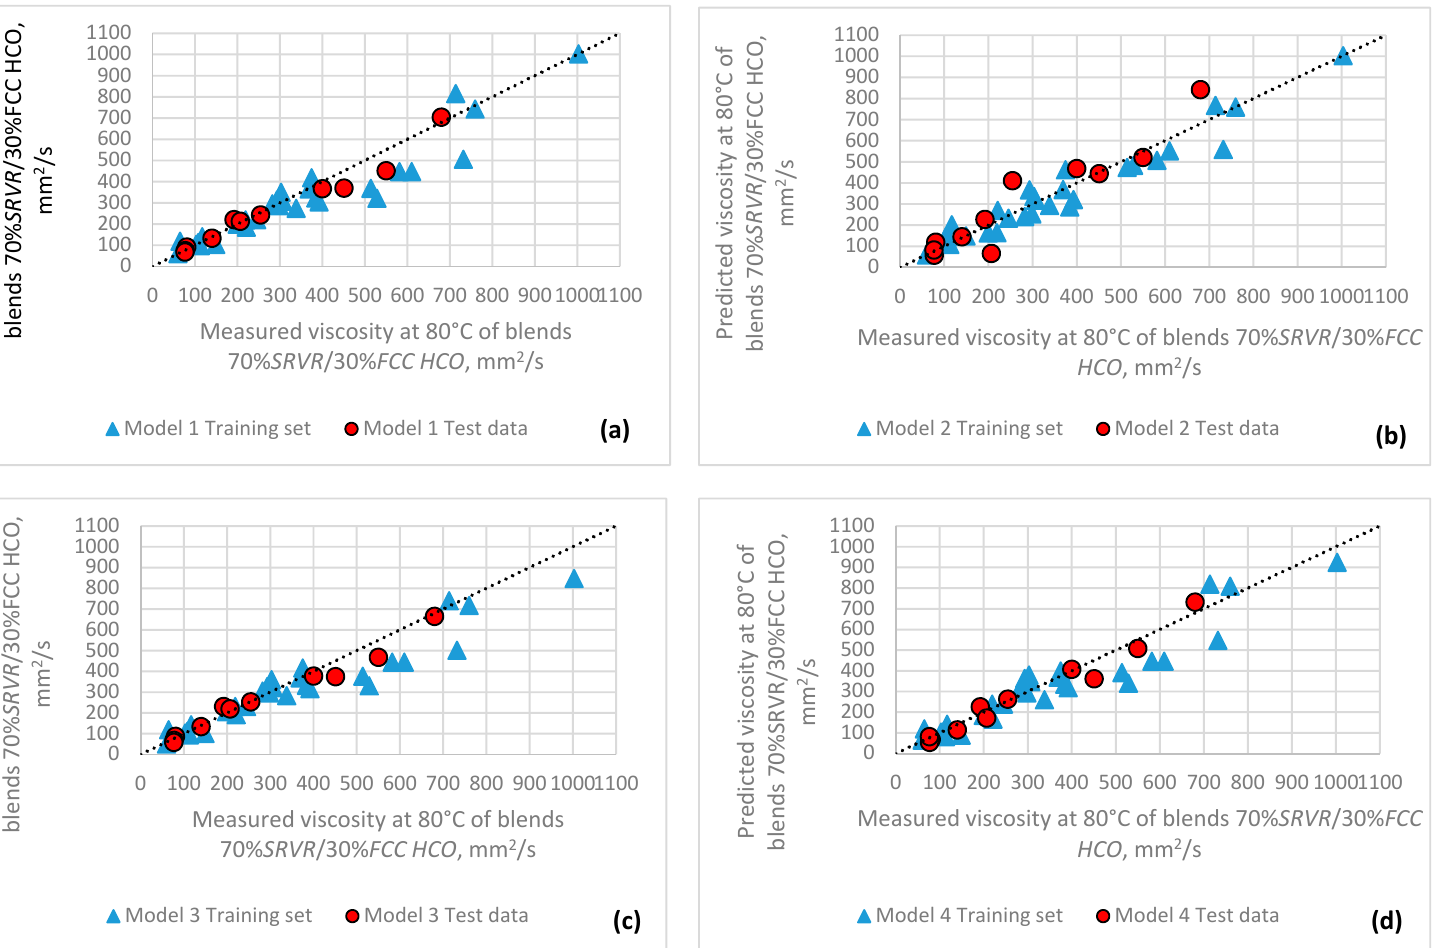
Figure 1. Agreement between measured data and that predicted by Models 1–4 for viscosities of blends of 70% SRVR /30% FCC HCO : ( a ) Model 1; ( b ) Model 2; ( c ) Model 3; ( d ) Model 4.